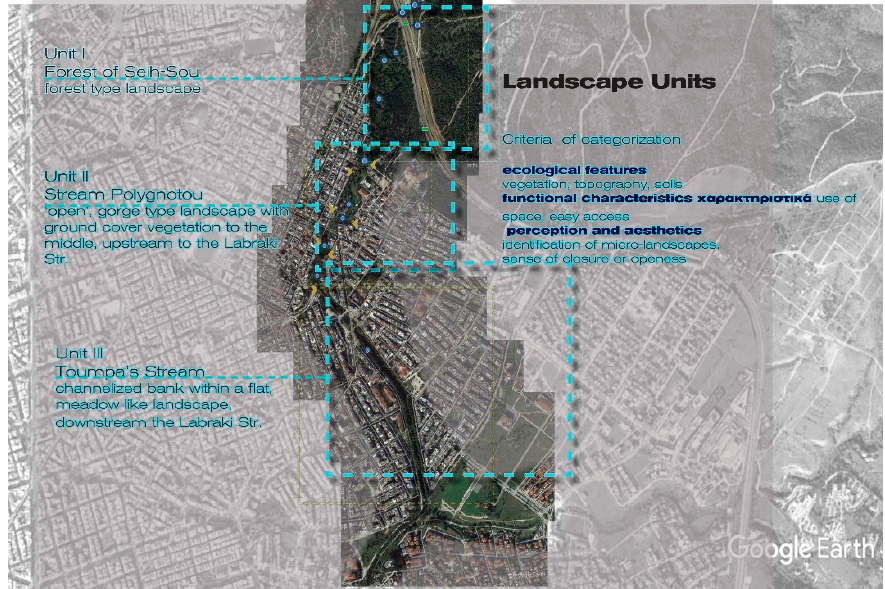
Figure 3. Stream Poygnotou and landscape units Source: